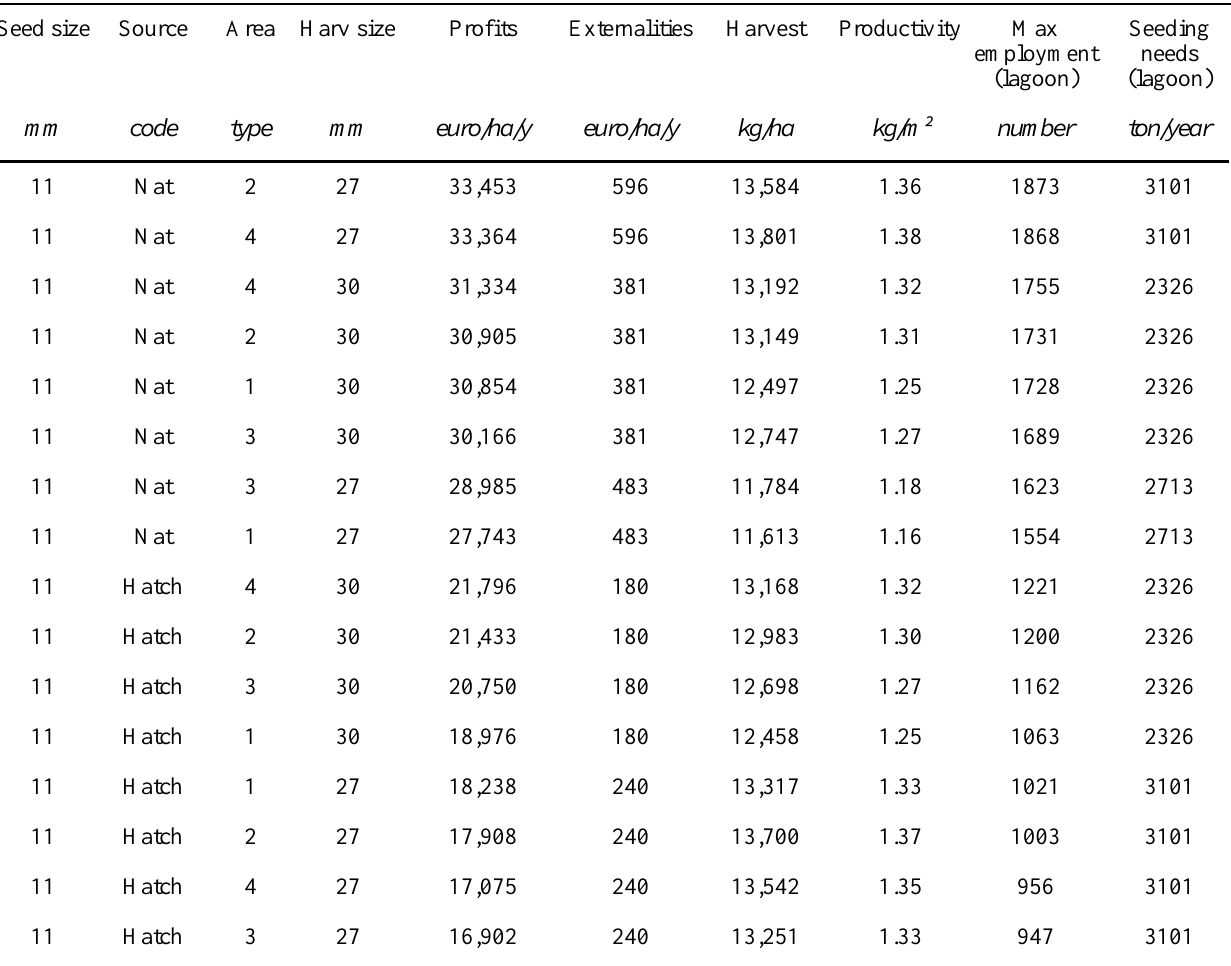
Table 7. Selected reference scenario results (rows), changing model parameters (columns 1-4). Columns 5-10: scenario results using selected indicators (profits, externalities, harvest, productivity, maximum employment, and seeding